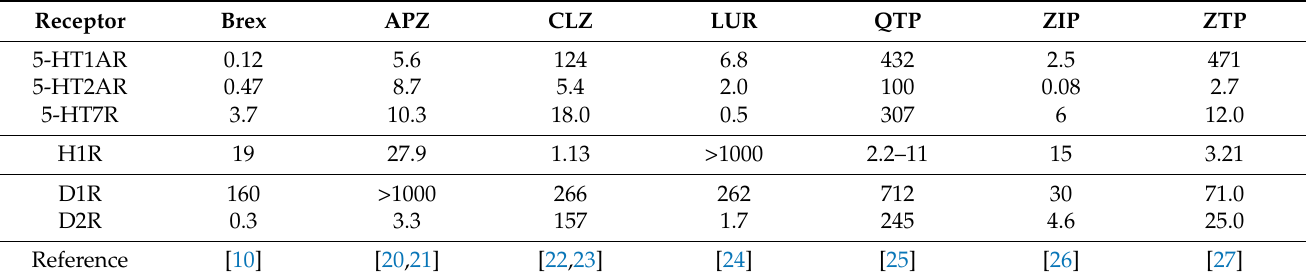
Table 1. Receptor binding profiles of mood-stabilising atypical antipsychotics. Brexpiprazole (Brex), aripiprazole (APZ), clozapine (CLZ), lurasidone (LUR), quetiapine (QTP), ziprasidone (ZIP), zotepine (ZTP) against serotonin (5-HT) type 1A (5-HT1AR), type 2A (5-HT2AR), type 7 (5-HT7R) receptor, histamine type 1 (H1R) receptor and dopamine receptors type 1 (D1R) and 2 (D2R). Data are equilibrium constant (Ki) values (nM).